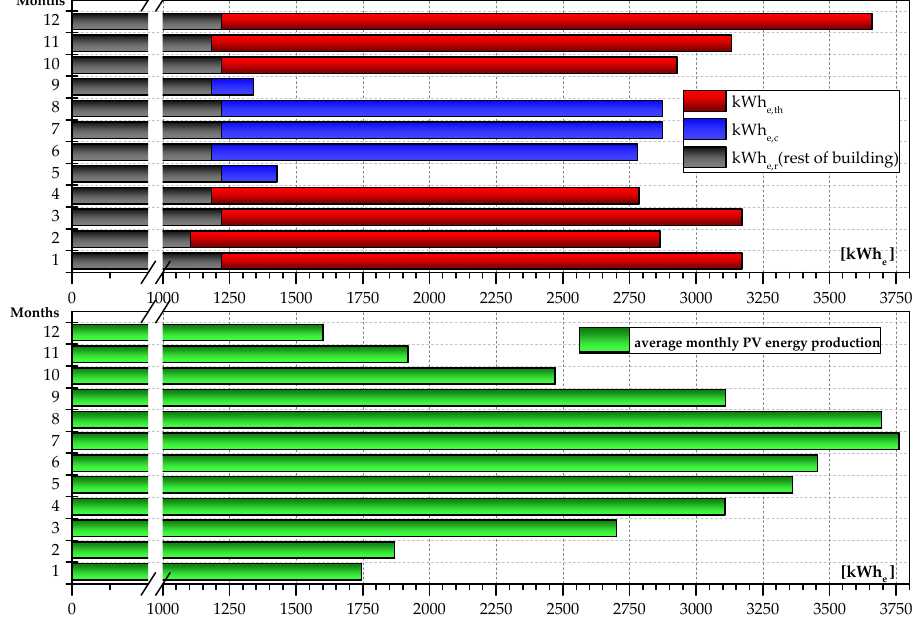
Figure 6. Total electrical energy consumption and average monthly PV production.